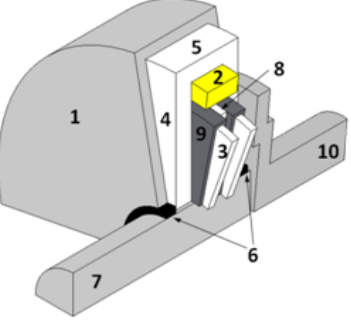
Figure 2. Exemplary two-disc MR clutch (N = 2)—general view and basic